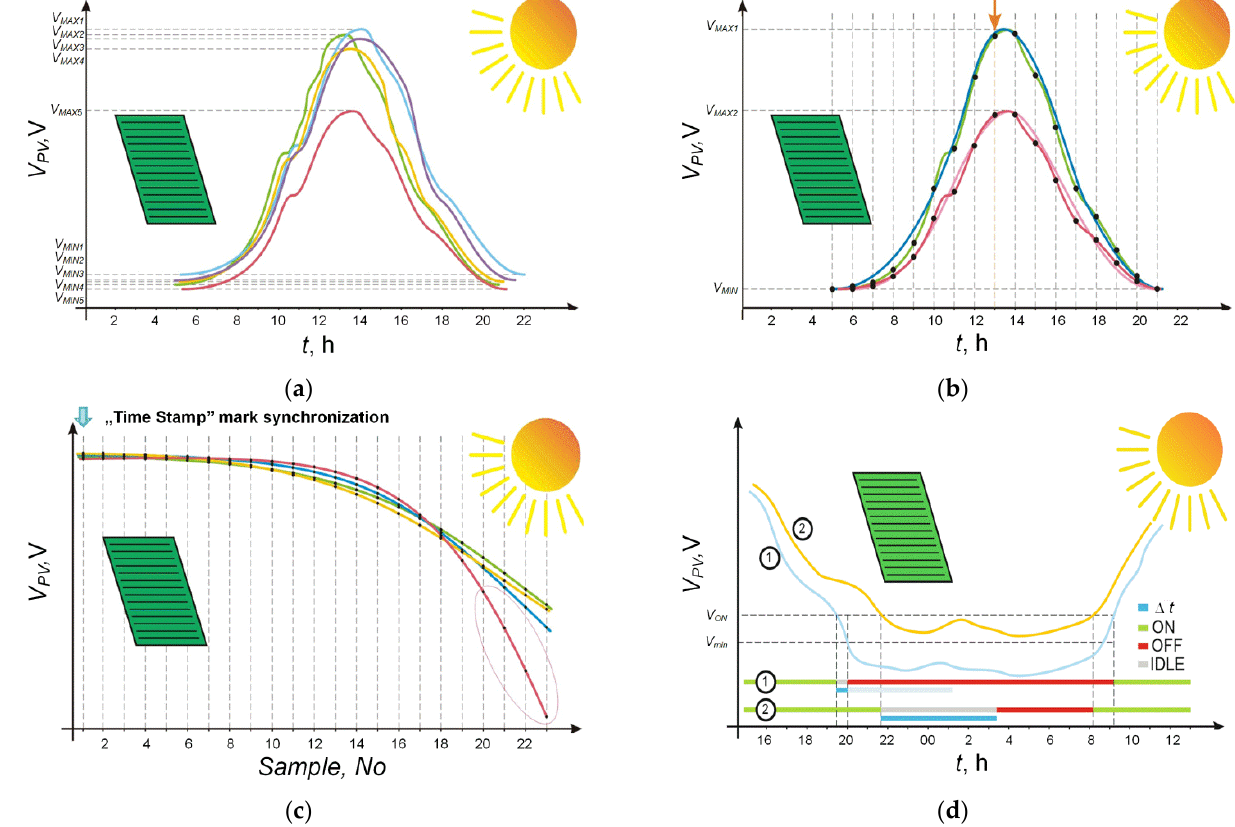
Figure 6. Exemplary V PV = f( t ) characteristics: ( a ) voltage at PV module terminals in similar lighting and environmental conditions; red line—malfunctioning module; ( b ) approximation of voltage characteristic, quasi-maximum measurement in 24 h intervals is pointed by arrow; ( c ) interpretation of diagnostic results, quasi-maximum values are in descending order; ( d ) operation of RFID sensor depending on output voltage level disturbances; voltage lower than V min (1) and voltage higher than V min (2) of supply voltage; ∆ t—time for the safe shutdown of the RFID sensor; ON/OFF—switching the system on/off; IDLE—termination of measurements in the daily cycle; V ON —threshold voltage of DC/AC inverter; V min —minimal supply voltage of RFID